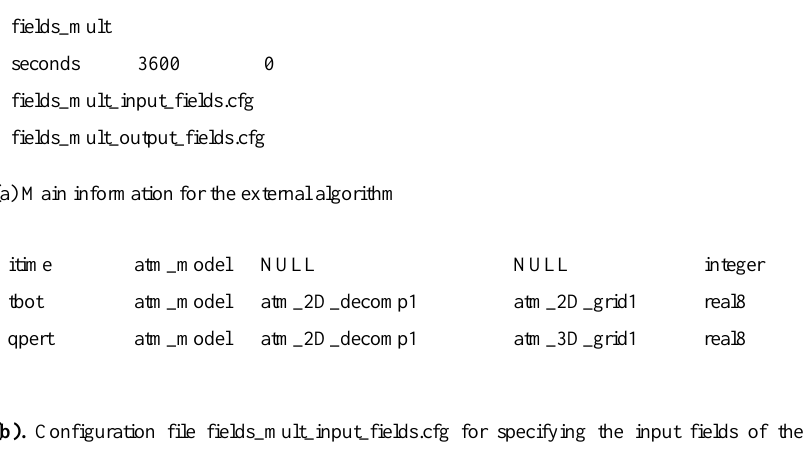
Fig. 4. C onfiguration files for an external algorithm. 12 Figure 4. Configuration files for an external algorithm.